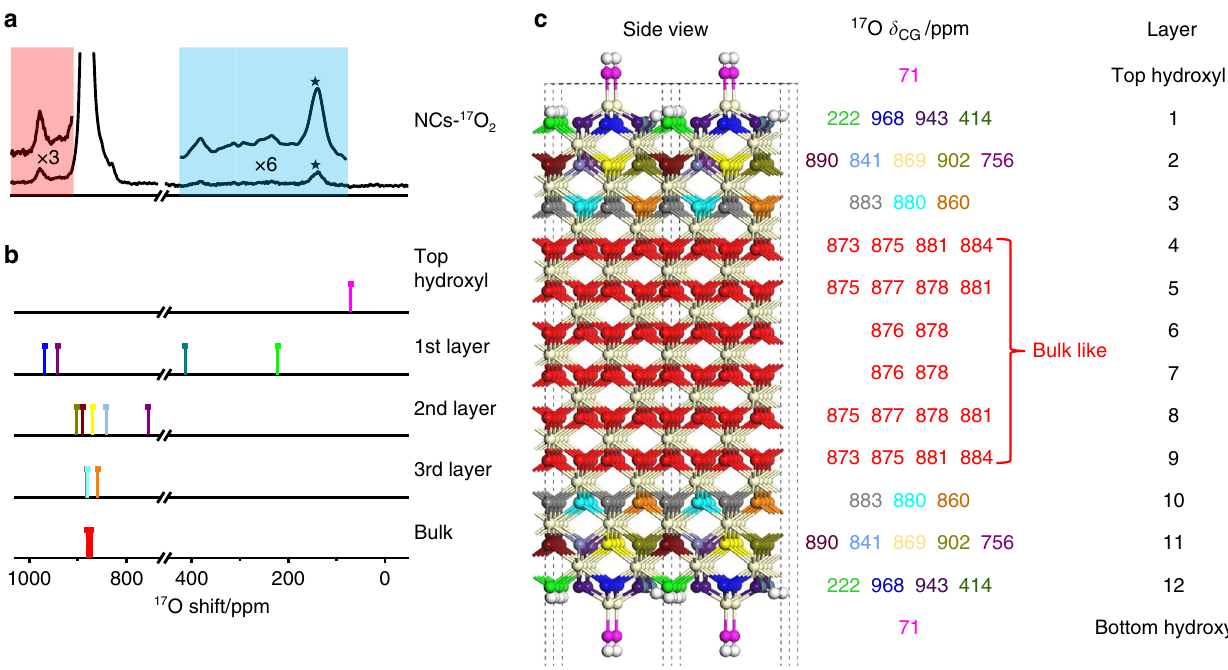
Fig. 4 17 O NMR spectrum, calculated 17 O NMR shifts and the structure model of ceria NCs- 17 O 2 . a 17 O Solid-State NMR spectra of ceria NCs- 17 O 2 (shown in Fig. 1). b The summarized 17 O NMR shifts ( δ CG s) predicted for the CeO 4 -t model with two H 2 O molecules dissociatively adsorbed on each surface unit (M 2 ). c The hydrated CeO 4 -t model used in the DFT calculations with NMR shifts ( δ CG s) for oxygen ions and the layer number shown on the right. Red, off- white, and white balls represent bulk oxygen, cerium, and hydrogen ions, respectively. Surface oxygen ions with different shifts are shown in different colors. The calculated 17 O NMR parameters for each oxygen ion are shown in Supplementary Table 12. A line broadening of 600 was applied to the enlarged spectrum in the blue region, no line broadening was applied to the enlarged spectrum in the red region.